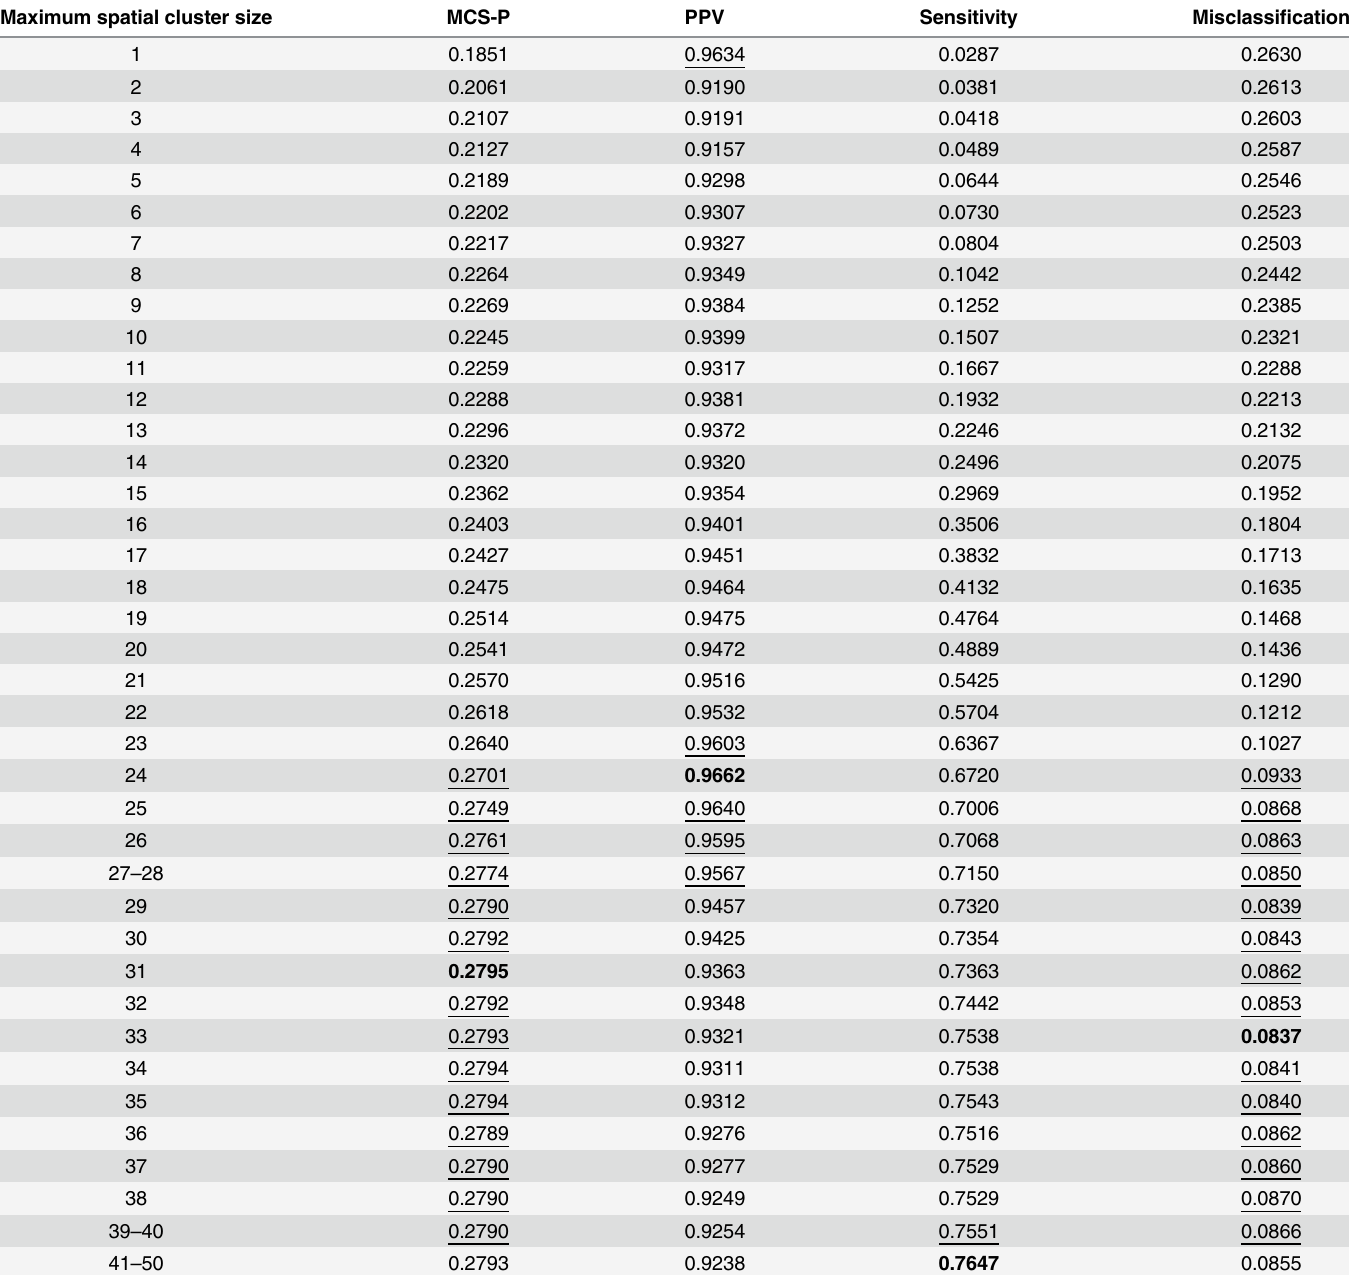
Table 5. Average performance measures for different maximum spatial cluster sizes in